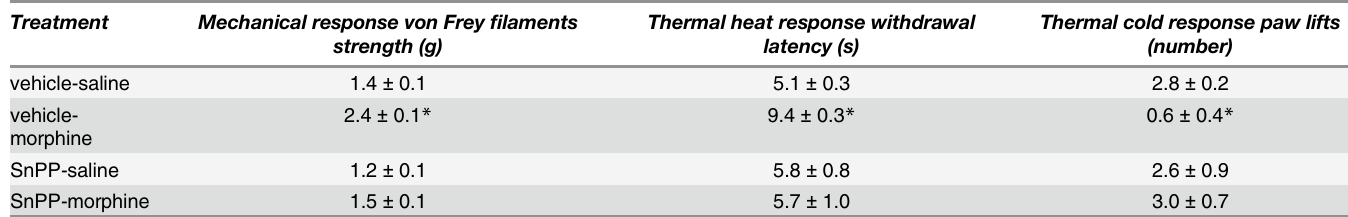
Table 1. Mechanical response (von Frey filaments strength, g), thermal heat response (withdrawal latency, s) and thermal cold response (paw lifts, number) on the hind paws of STZ injected mice treated with vehicle-saline, vehicle-morphine, SnPP-saline or